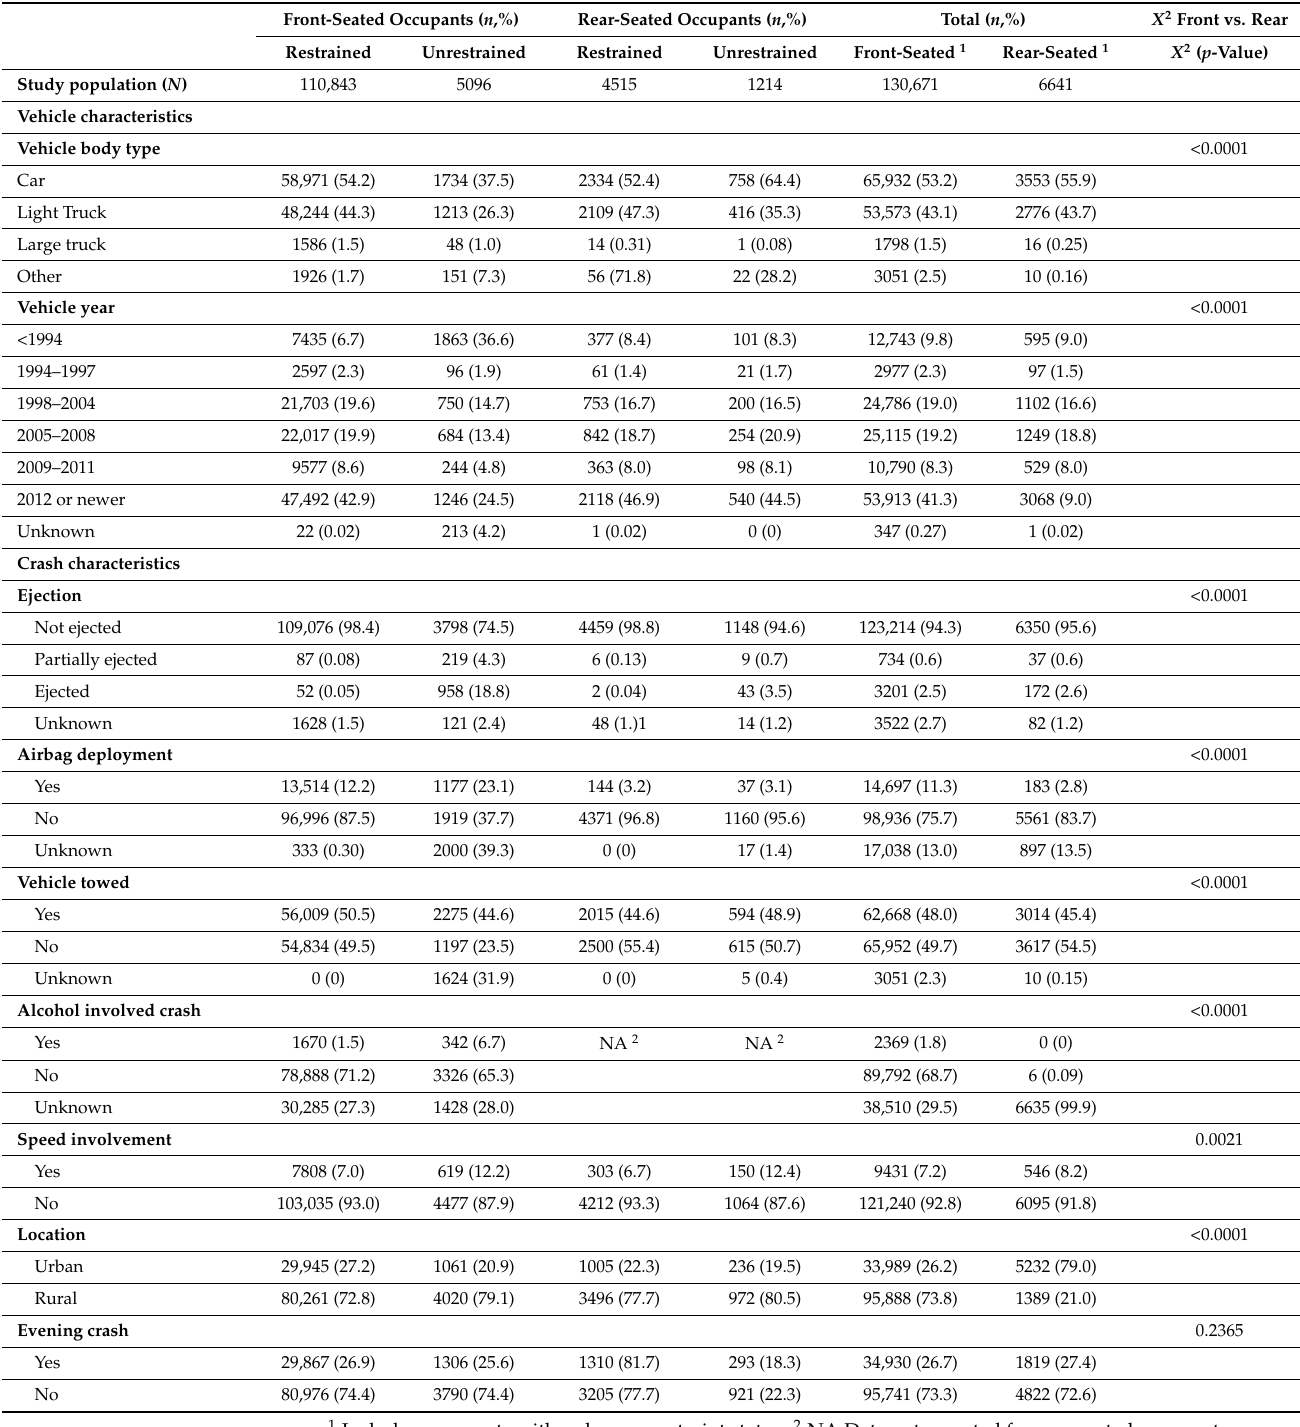
Table 2. Vehicle and Crash Characteristics for Adult Occupants Involved in a Motor Vehicle Crash in New York State, Front-Seated and Rear-Seated Occupants by Restraint Status, Crash Outcome Data Evaluation System (CODES), 2016–2017. Front-Seated Occupants ( n ,%) X 2 Front vs.